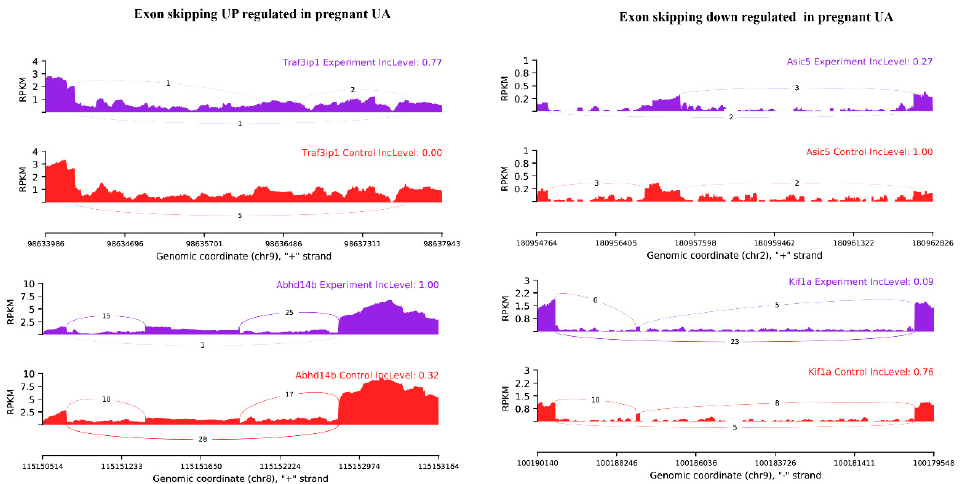
Figure 7. ( A ) Total number of genes with alternative splicing increase and ( B ) alternative splicing decrease and their types overlaps in pregnant compared with non-pregnant UA. A5SS: alternative 5 ′ splice, A3SS: alternative 5 ′ splice, MXE: Mutually exclusive exons, RI: retained intron, SE: Exon skipping. ( C ) The total number of both differentially expressed and alternatively spliced genes in pregnant UA.